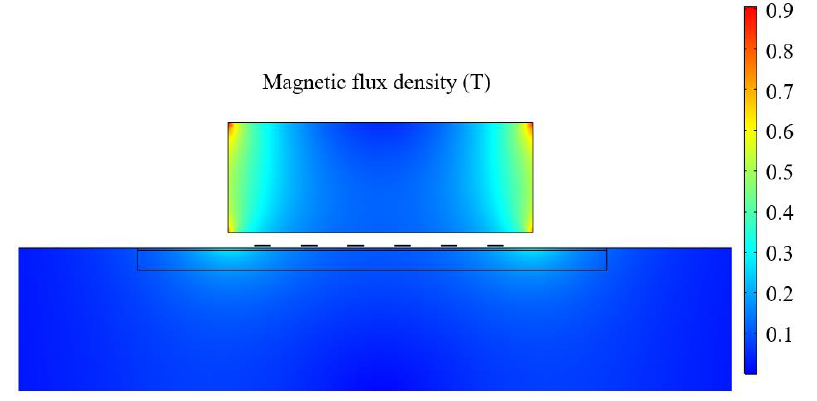
Figure 9. Magnetic flux density distribution of permanent magnet.